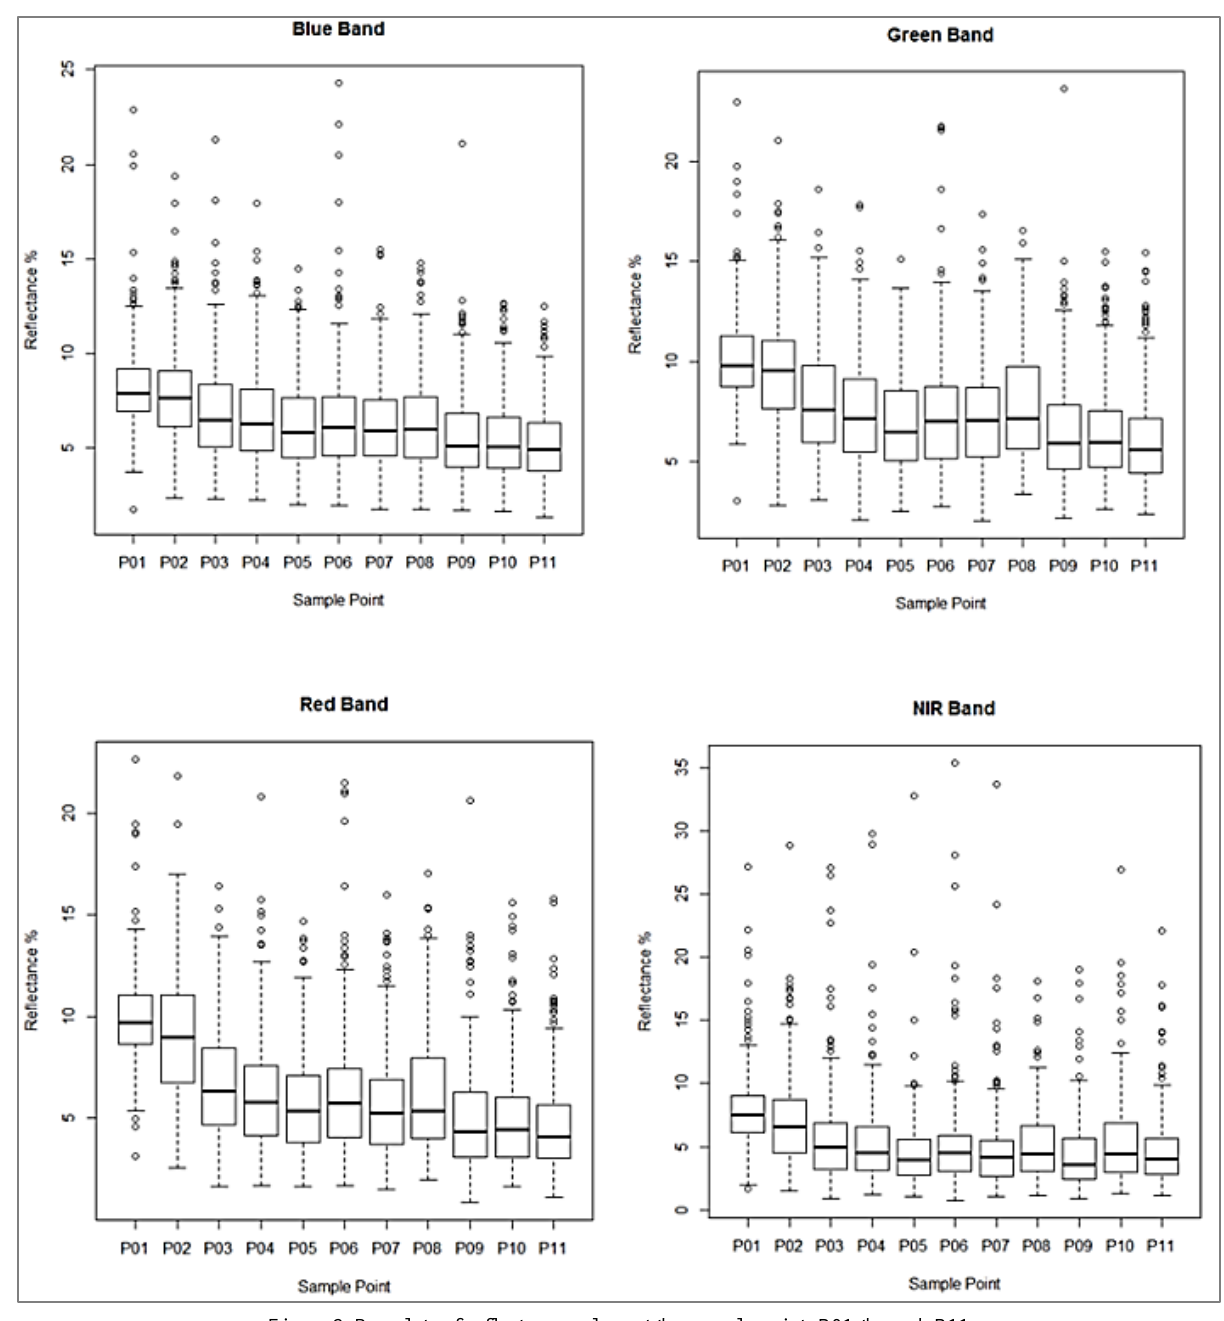
Figure 2. Boxplots of reflectance values at the sample points P01 through